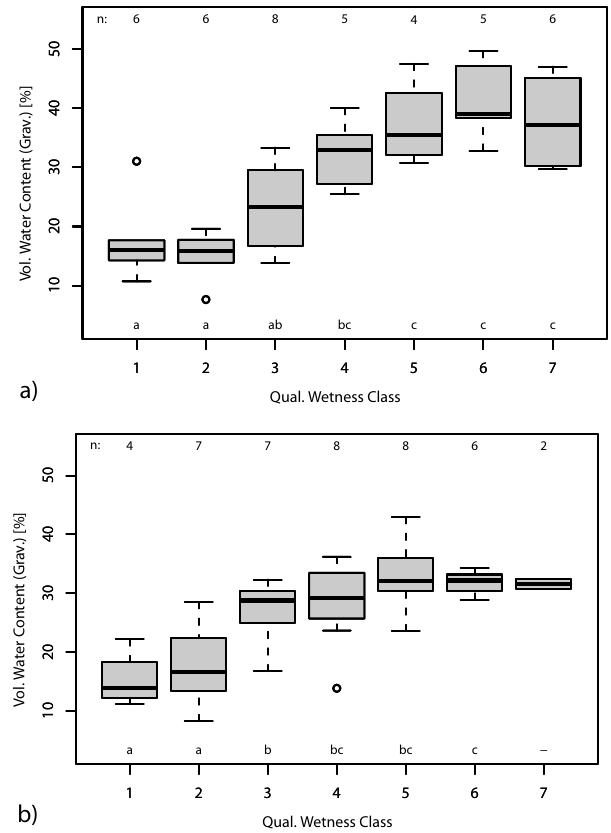
Figure 3. Volumetric water content for soil samples of each wet- ness class determined by the gravimetric method (a) during test in April 2014 and (b) during test in June 2014. ( n : sample size, letters: statistically not significantly different groups.)